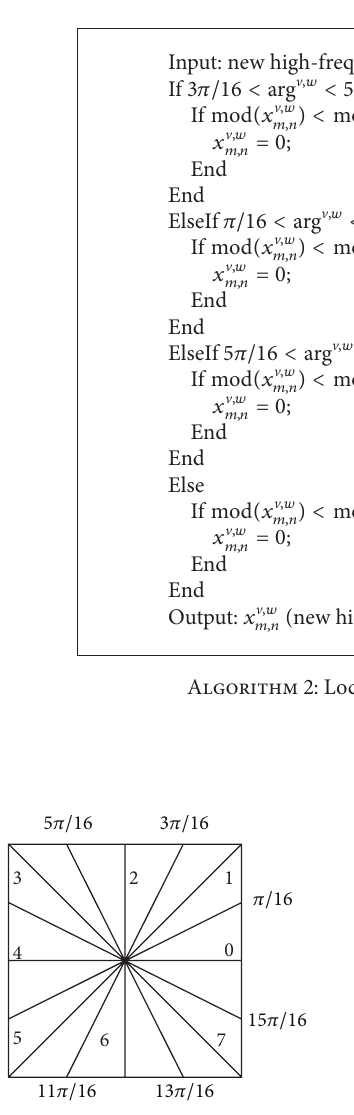
Figure 3: Directional subband equivalent